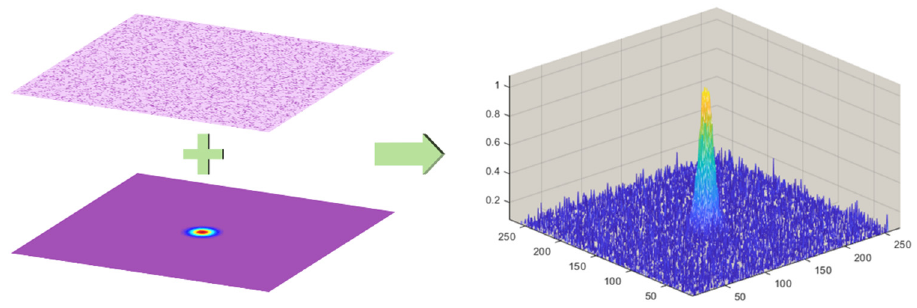
Figure 5. Simulation of noise generation in laser spot image.